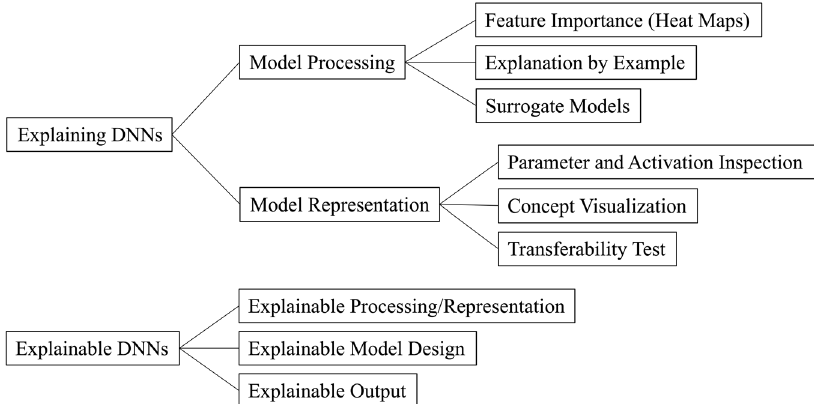
Fig. 2 Overview of approaches to achieving explainability within DNNs. This framework is extended from the machine learning explainability taxonomy presented by Gilpin et al. 31 and the format is inspired by the work of Arrieta et al. 25